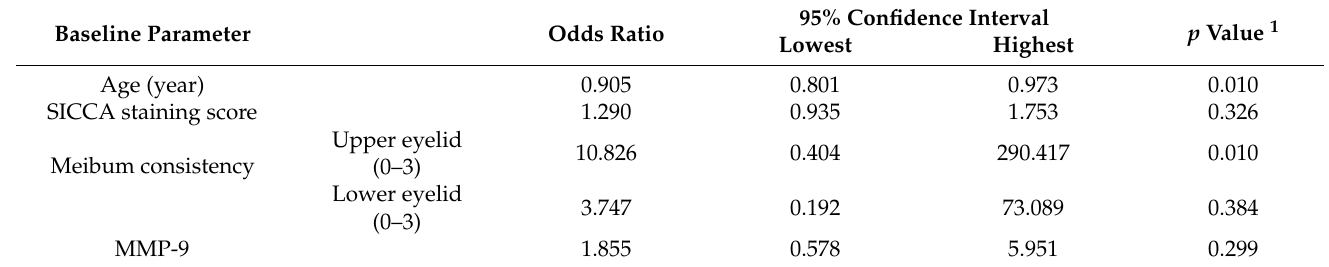
Table 5. Multivariate analysis comparing odds ratios of baseline parameters to mean differences of meibomian gland grade in patients with moderate to severe meibomian gland